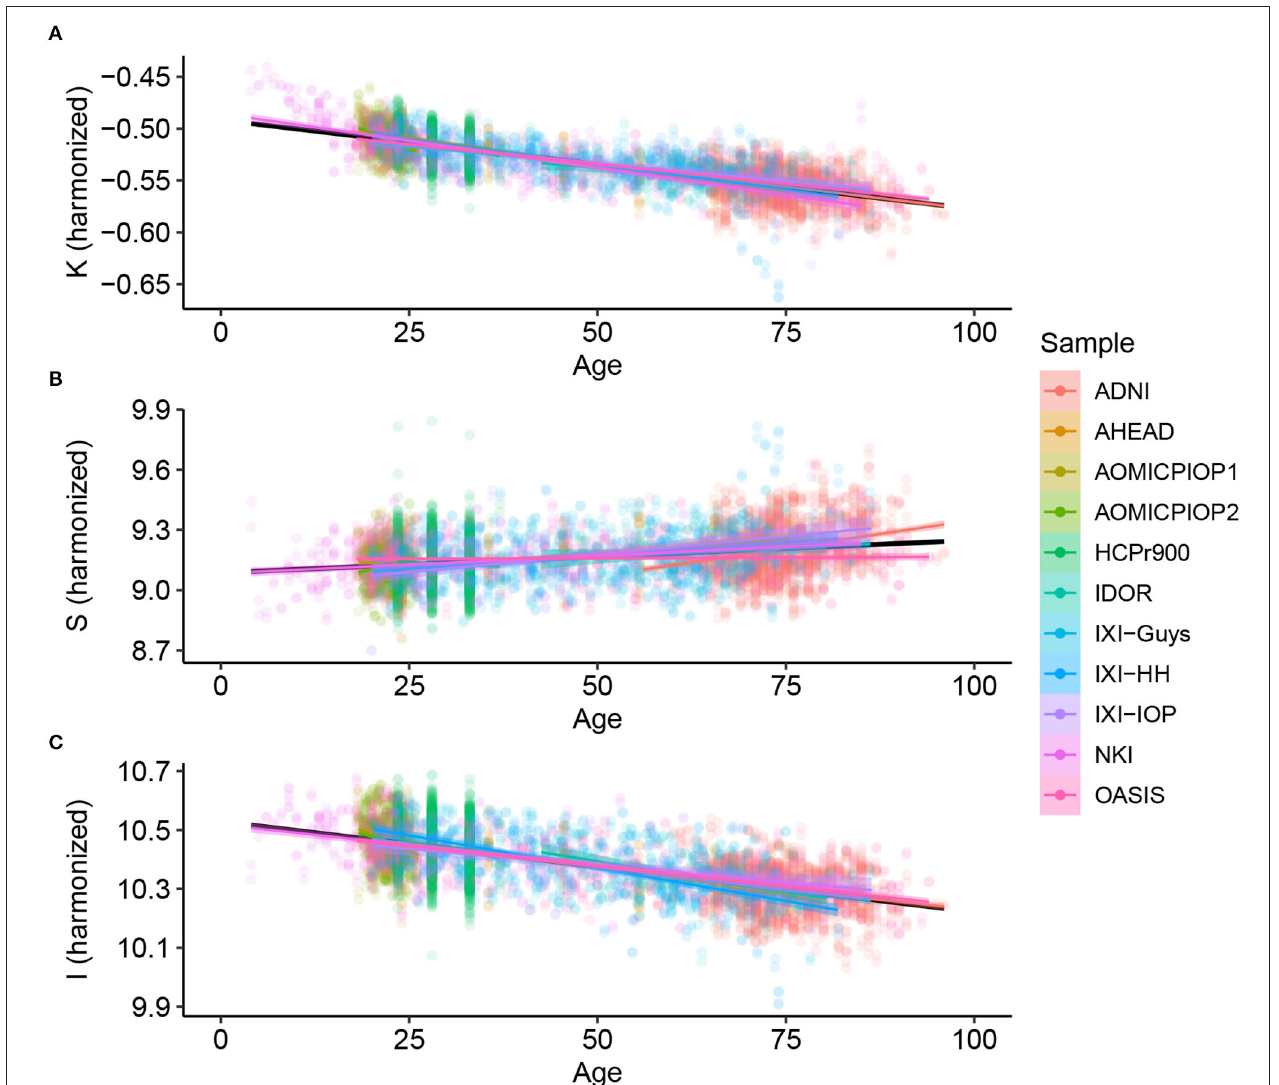
FIGURE 2 | Cortical folding variables (A) K, (B) S, and (C) I through age for Healthy Controls after harmonizing in the primary morphological variables T, AT , and AE (removing the estimated residual from the Linear Mixed Model).